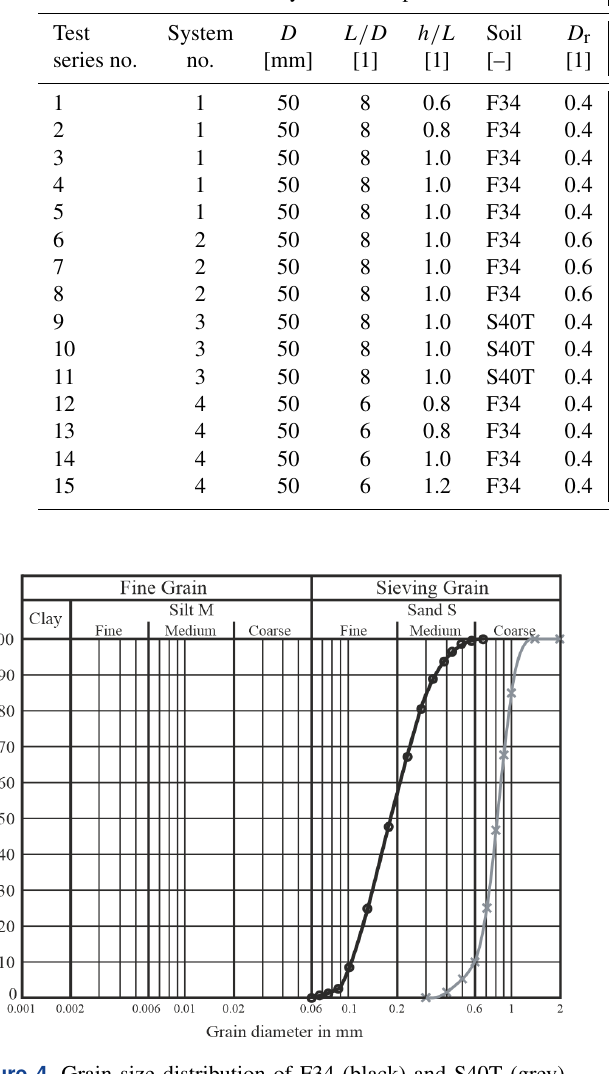
Pile–soil system description